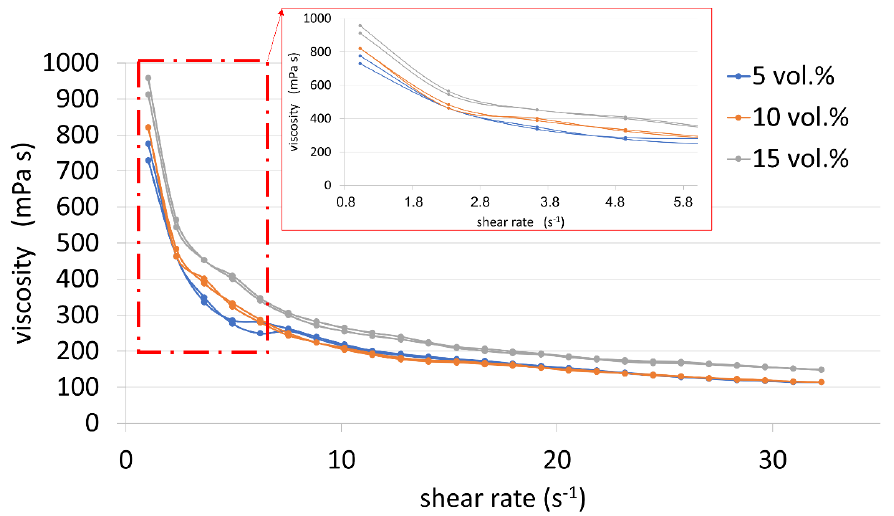
Figure 6. Viscosity curves of